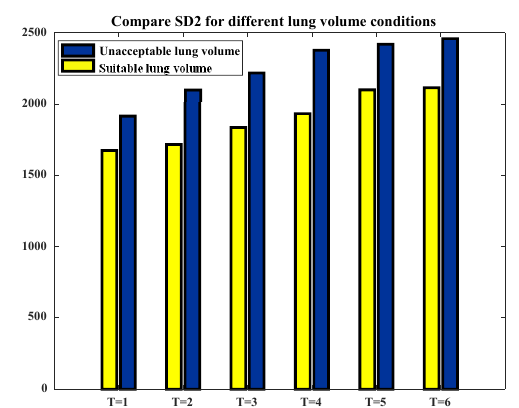
Fig. 7. Comparison of the SD2 parameter for different value of the